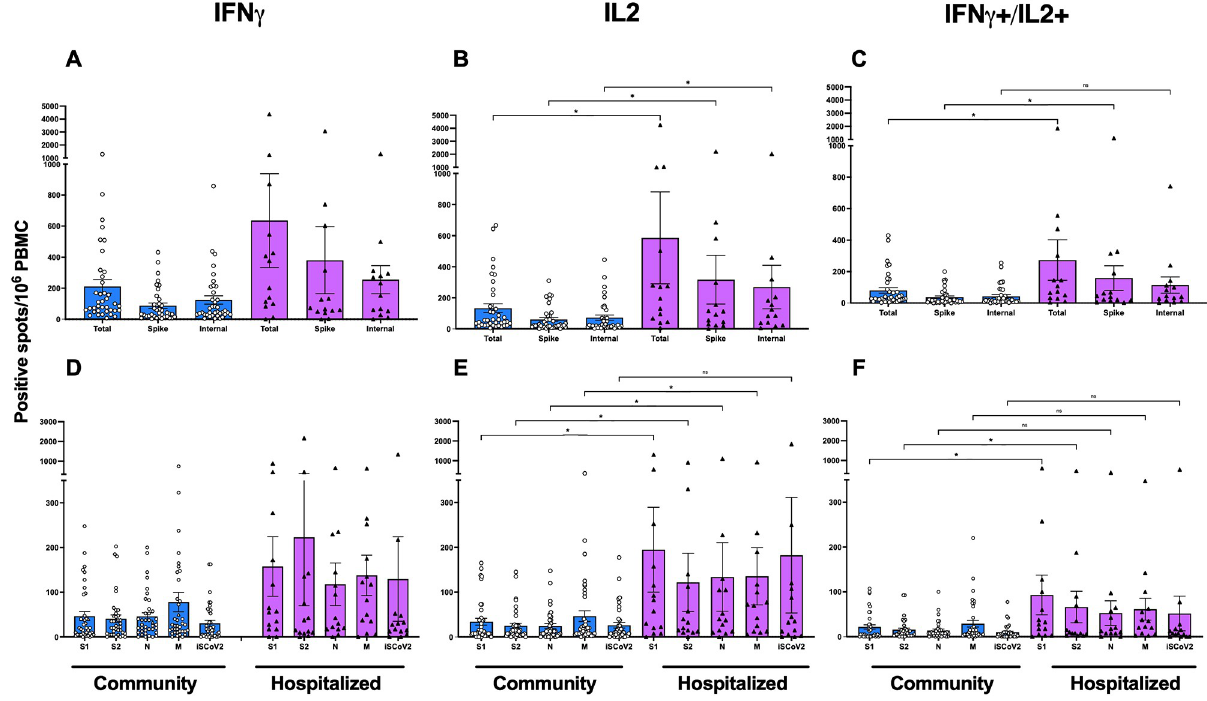
Fig 3. SARS CoV-2 specific T-cell responses in community and hospitalized patients. T-cell immune responses were evaluated by measuring the number of SARS-CoV-2 specific IFN- γ (A, D), IL-2 (B, E) and IFN- γ + + IL-2 + (C, F) secreting T-cells, (spot forming units) (SFU) after infection using the FluroSPOT assay. A-C; peripheral blood mononuclear cells (PBMC) were stimulated with peptide pools to measure the total (S1, S2, N, M), internal (N and M), and spike (S1 and S2) specific SARS-CoV-2 responses. D-F; the SARS CoV-2 specific S1, S2, M, N and inactivated SARS CoV-2 hCoV-19/ Norway/Bergen-01/2020 virus (ISCoV-2). Each symbol represents the SARS-CoV-2 IFN- γ /IL-2 response (spot forming units (SFU) per 1 × 10 6 cells) after stimulation with virus spike antigen. The horizontal bars represent the mean IFN- γ response for each time point ± standard error of the mean. Statistical differences between different antigens or hospitalized and community dwelling subjects were determined by the nonparametric Kruskal– Wallis multiple comparisons test ( � = P < 0.05, �� = P < 0.005).